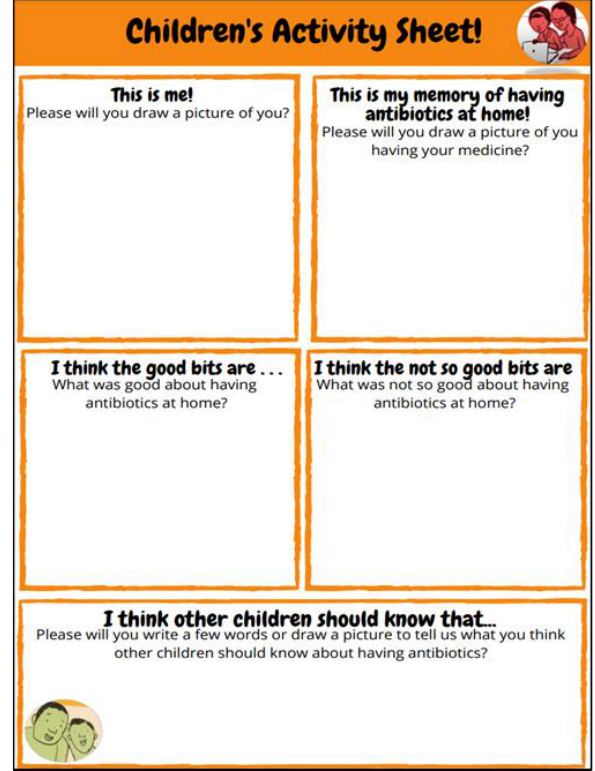
Figure 2. Children ’ s Activity Sheet. Figure 2. Children’s Activity Sheet.